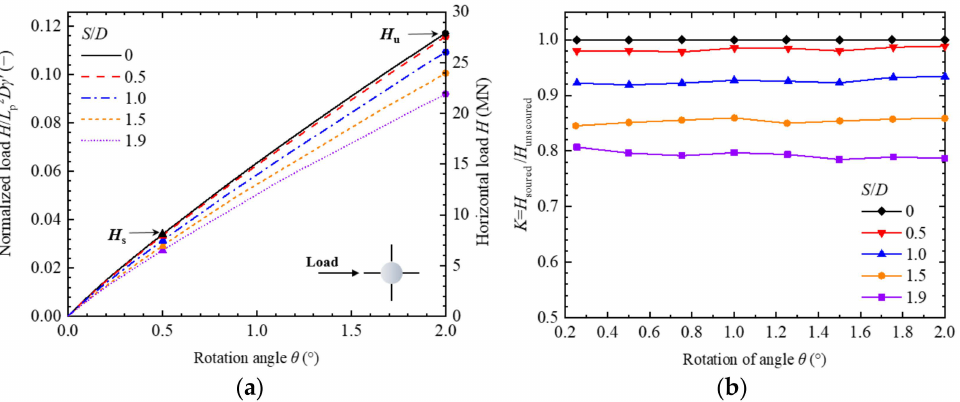
Figure 8. The effects of scour depth on bearing capacity of winged monopiles: ( a ) load–displacement curves of winged monopiles with various scour depths; ( b ) variation in lateral bearing capacity ratio with displacement at different scour